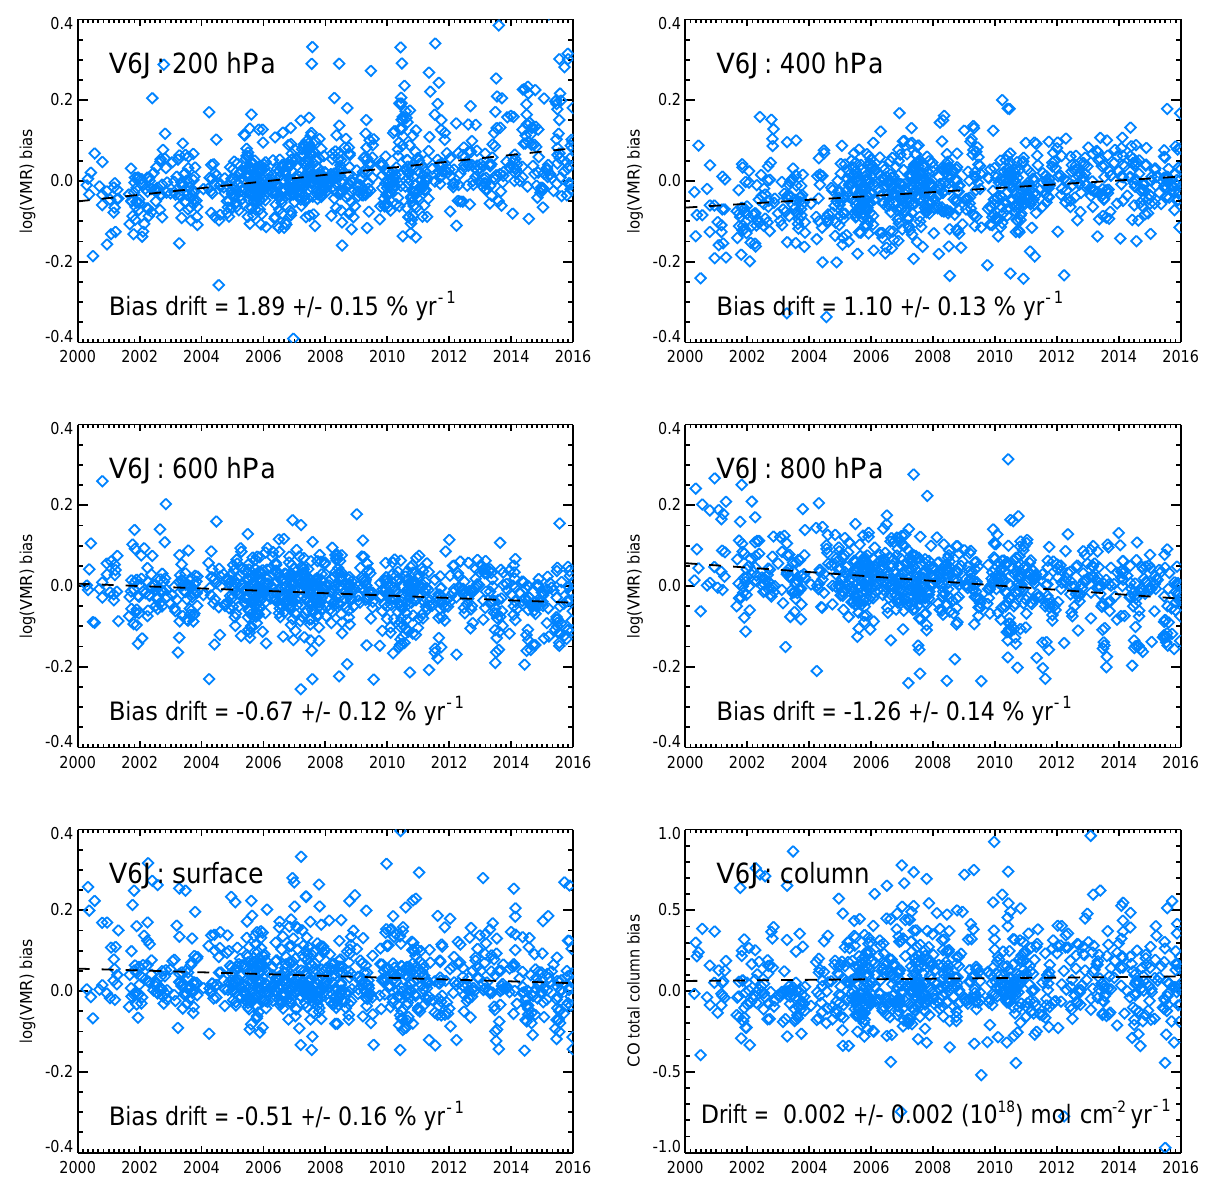
Figure 15. Retrieval bias drift for V6 TIR-NIR products based on the NOAA flask measurements. See caption to Fig. 11.